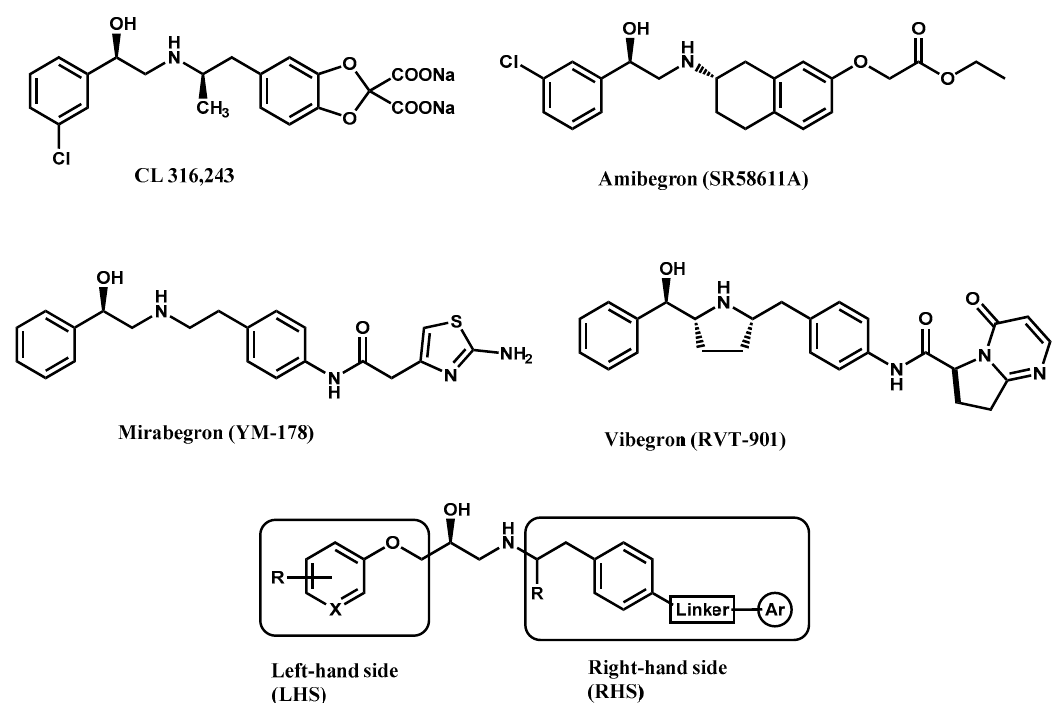
Figure 1. Structures of CL 316,243, amibegron, mirabegron, vibegron and the general structure of the aryloxypropanolamines studied here.